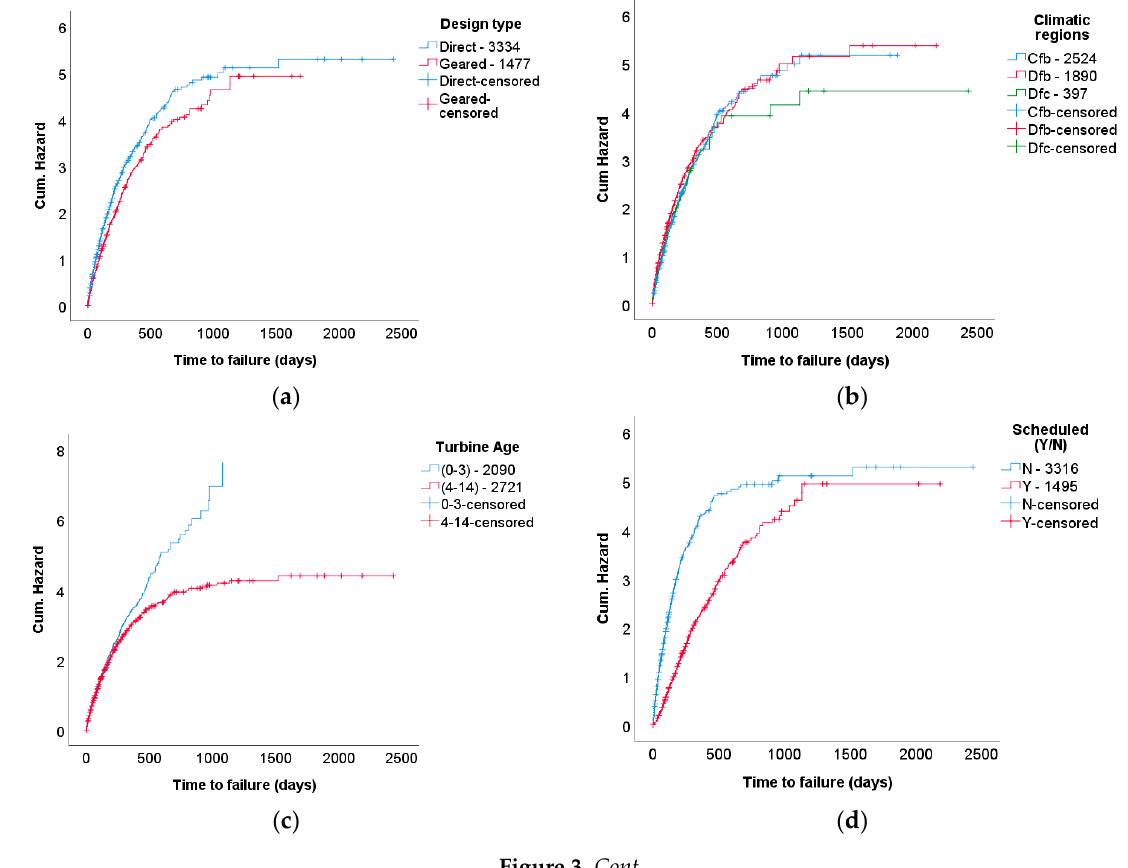
Table 6. Cox regression results for the factors that satisfy the proportionality